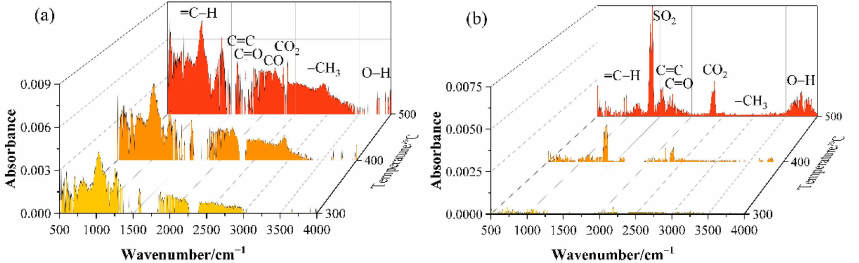
Figure 4. FTIR spectra of gaseous products from the pyrolysis of ( a ) the Geniai shale and ( b ) the Wenjiaba shale at 300 ◦ C, 400 ◦ C and 500 ◦